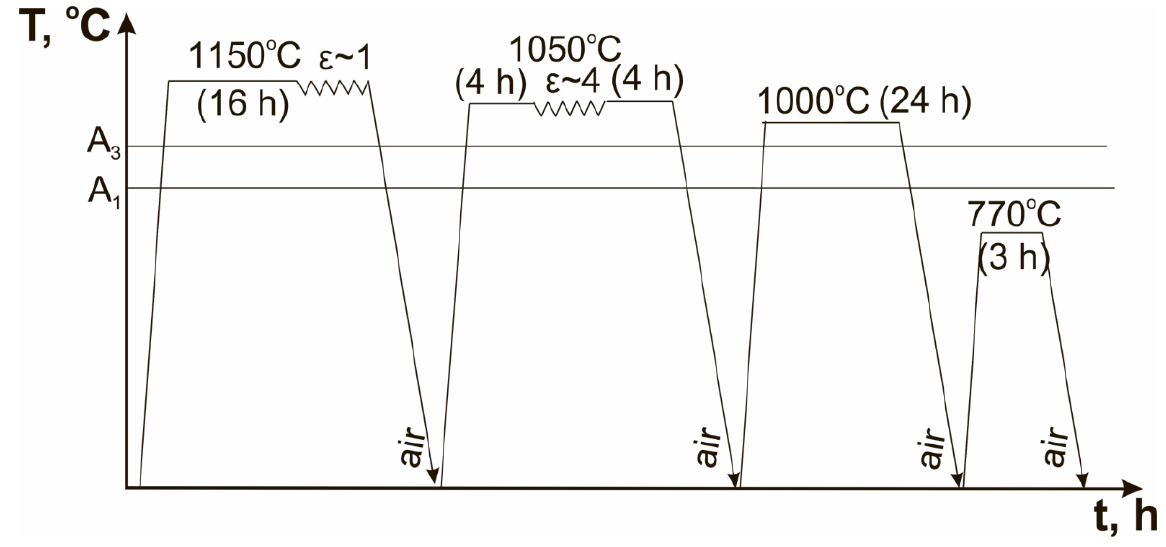
Figure 1. Schema of the TMP